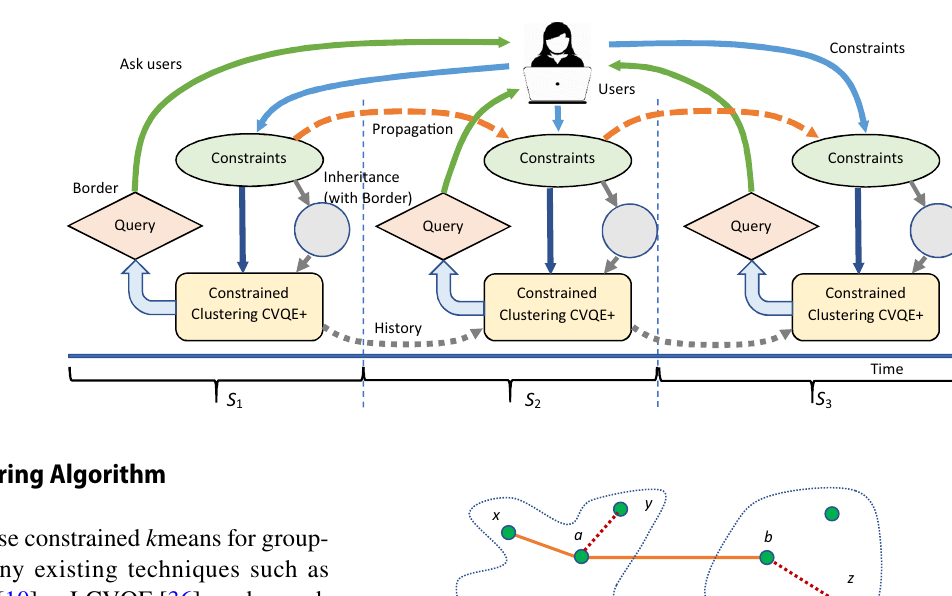
Fig. 1 Our active temporal clustering framework